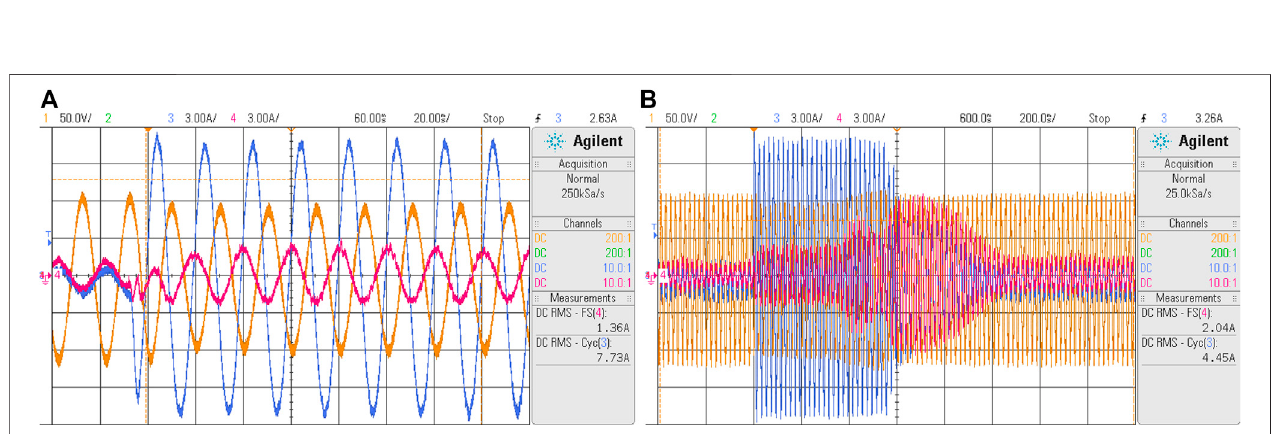
FIGURE12| Transientduringheavyloadchange-inductionmotorstartup.Line-neutralvoltageatreferencephase(yellow),referencephasecurrentofgrid-forming converter (blue), and reference phase current of grid-support converter (magenta). (A) initial transient, and (B) total transient.